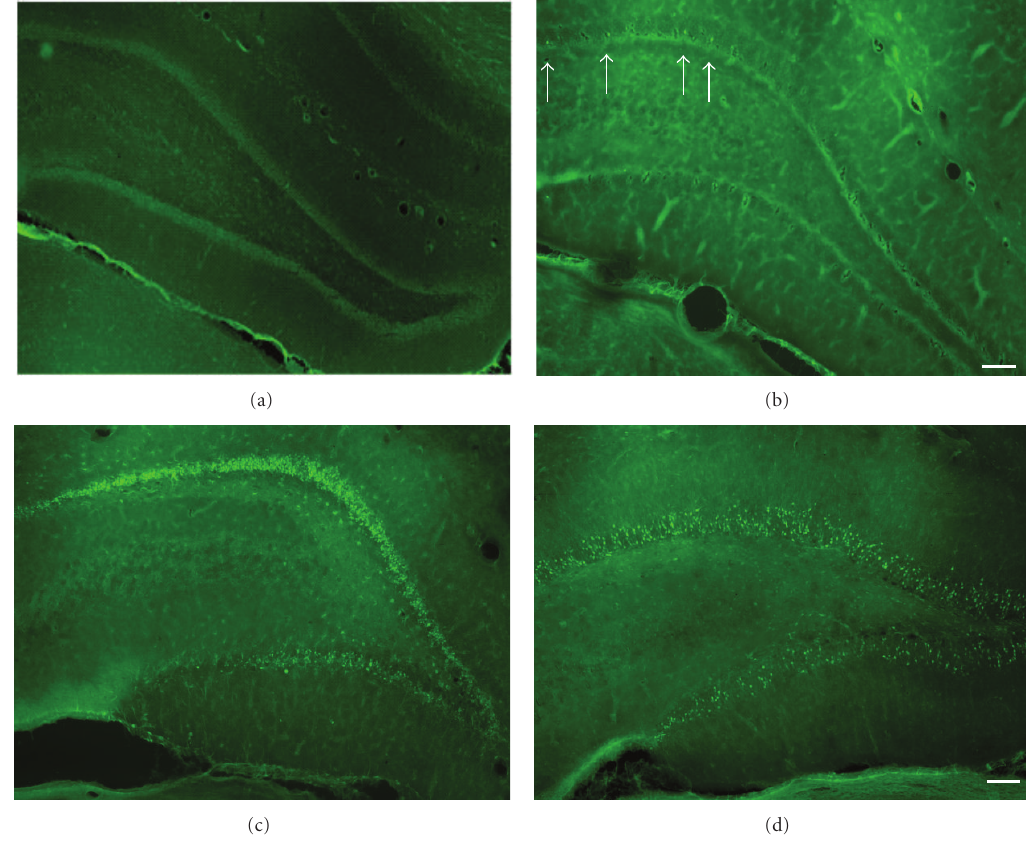
Figure 1: Representative Fluoro-Jade B labeled sections taken from a control (a) and adrenalectomized (ADX) rats at 3 days (b), 8 weeks (c), and 23 weeks (d) after surgery. No Fluoro-Jade B positive cells were apparent in control tissue (a). Fluoro-Jade B positive cells were evident by 3 days after ADX (indicated by arrows) and appeared in the superior lateral blade of the dentate gyrus (b). At 8 weeks after ADX surgery, Fluoro-Jade B positive cells were evident throughout the entire granule cell layer but was still most concentrated in the superior, lateral blade (c). Fluoro-Jade B labeling has substantially decreased at the 23-week time point but was still apparent throughout the entire dentate gyrus granule cell layer (d). Scale bar = 100 µ